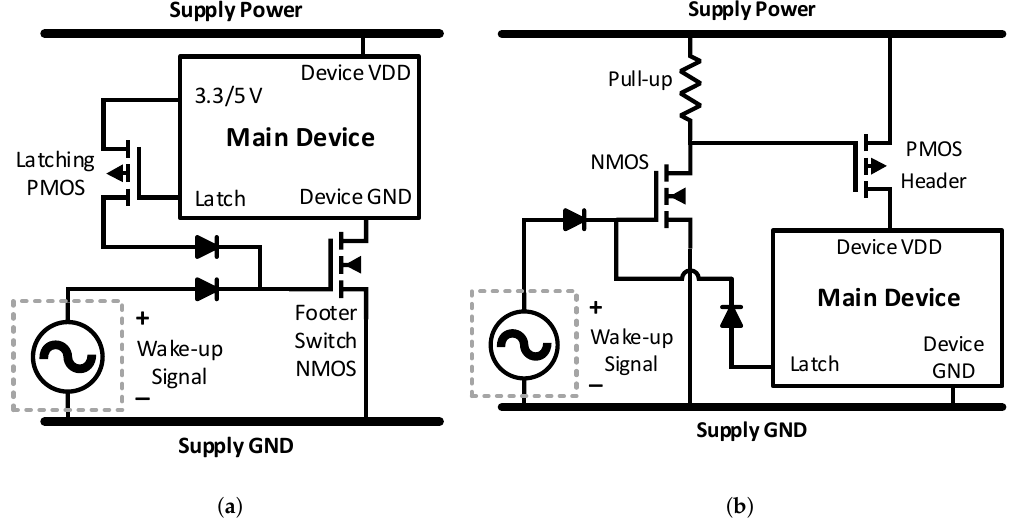
Figure 1. ( a ) The footer switch requires a wake-up signal to connect the device ground to supply ground. The main device can then latch the gate of the footer switch to remain powered. ( b ) The header switch uses a P-type MOSFET (PMOS) to disconnect the device VDD from supply